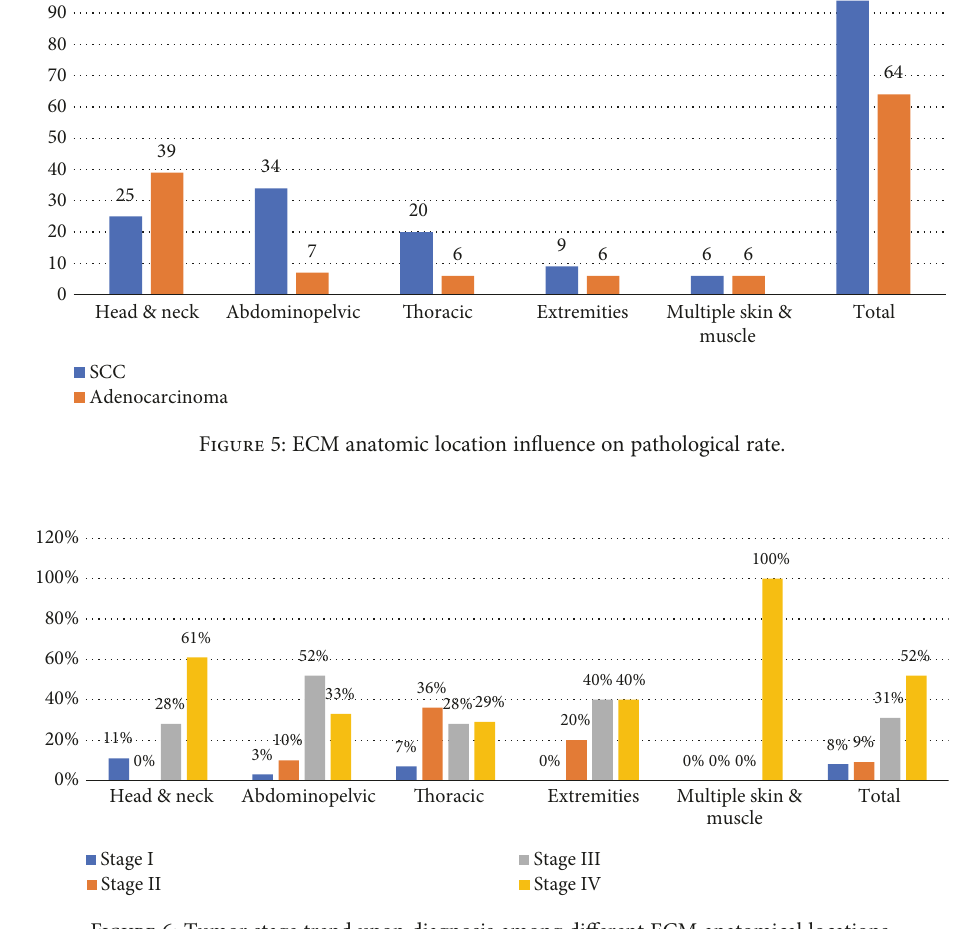
Figure 6: Tumor stage trend upon diagnosis among di ff erent ECM anatomical